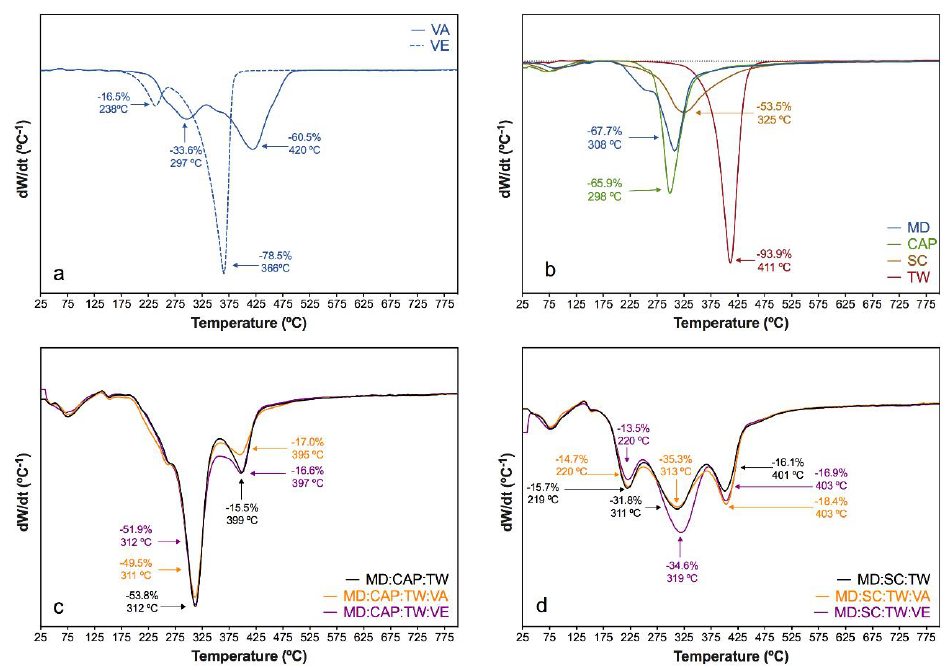
Figure 6. DTGA curves under an inert atmosphere of ( a ) vitamin A (VA) and vitamin E (VE); ( b ) MD, CAP, SC, and TW components; and comparison of the vitamin encapsulation using ( c ) MD:CAP:TW and ( d ) MD:SC:TW matrices.